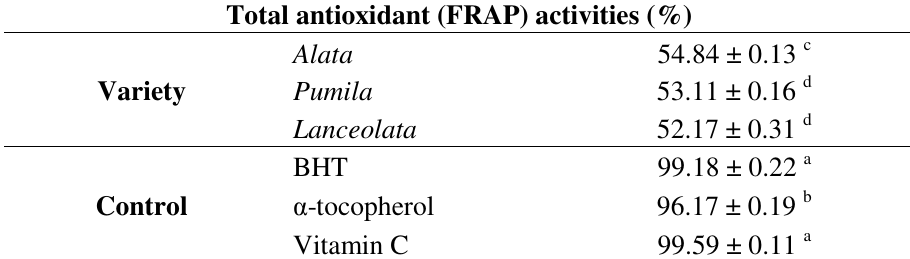
Table 4. Total antioxidant (FRAP) activities of the leaf part in all varieties of L. pumila at concentration of 400 µ g/mL. BHT, α -tocopherol and Vitamin C were used as positive